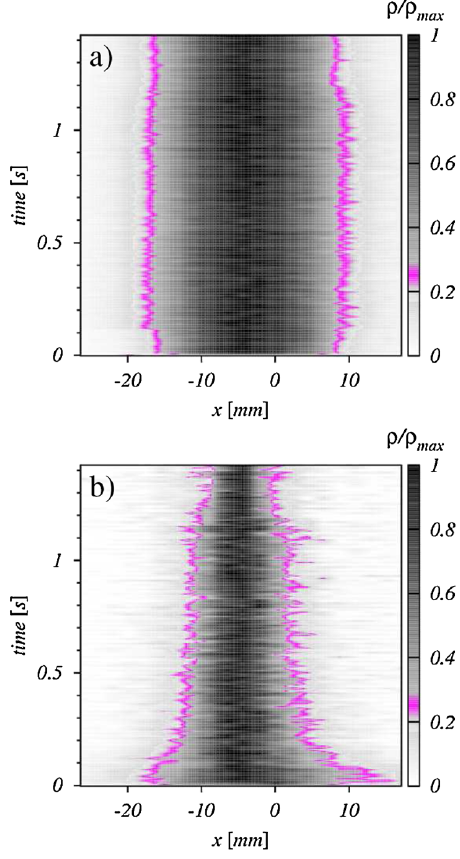
FIG. 12. Low intensity bunched beam: (a) Beam evolution at : 3185 . (b) Beam evolution at Q Q x ¼ 4